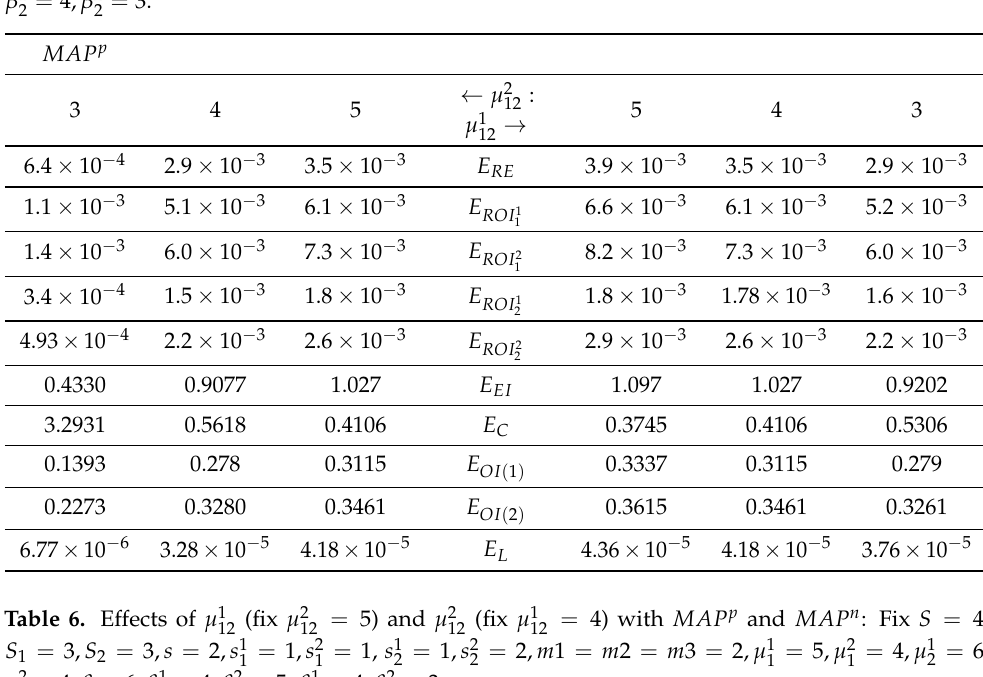
= 4): Fix S = 4, S (fix µ 1 12 12